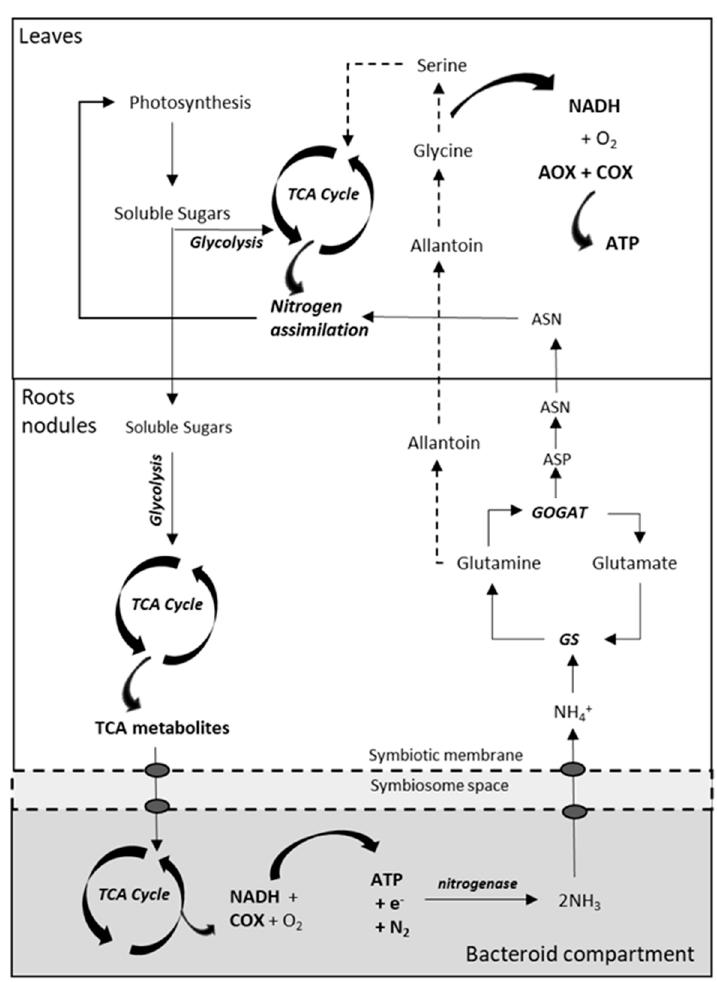
Figure 4. Simplified overview of the nitrogen-fixing pathways in nodulated legumes, conditioned by the demand for ATP synthesis for nitrogenase activity in determinate and indeterminate nodules. Soluble sugars are catabolized via glycolysis to respiratory substrates for the synthesis of TCA metabolites, which are transported across the peribacteroid and bacteroid membranes to fuel the TCA cycle and respiration in the bacteroid. The ammonia produced during nitrogenase activity is exported to the plant and assimilated by GS and GOGAT enzymes. In determinate nodules, glutamine is converted to ureides (allantoin), that are decarboxylated in metabolic pathways of photorespiration, contributing to the accumulation of NADH in mitochondria. In indeterminate nodules, glutamine and glutamate are further converted to asparagine and aspartate to be incorporated into the nitrogen metabolism of leaves. ASN, asparagine; ASP, aspartic acid; TCA, tricarboxylic acid cycle. Modified from Liu et al. [131].